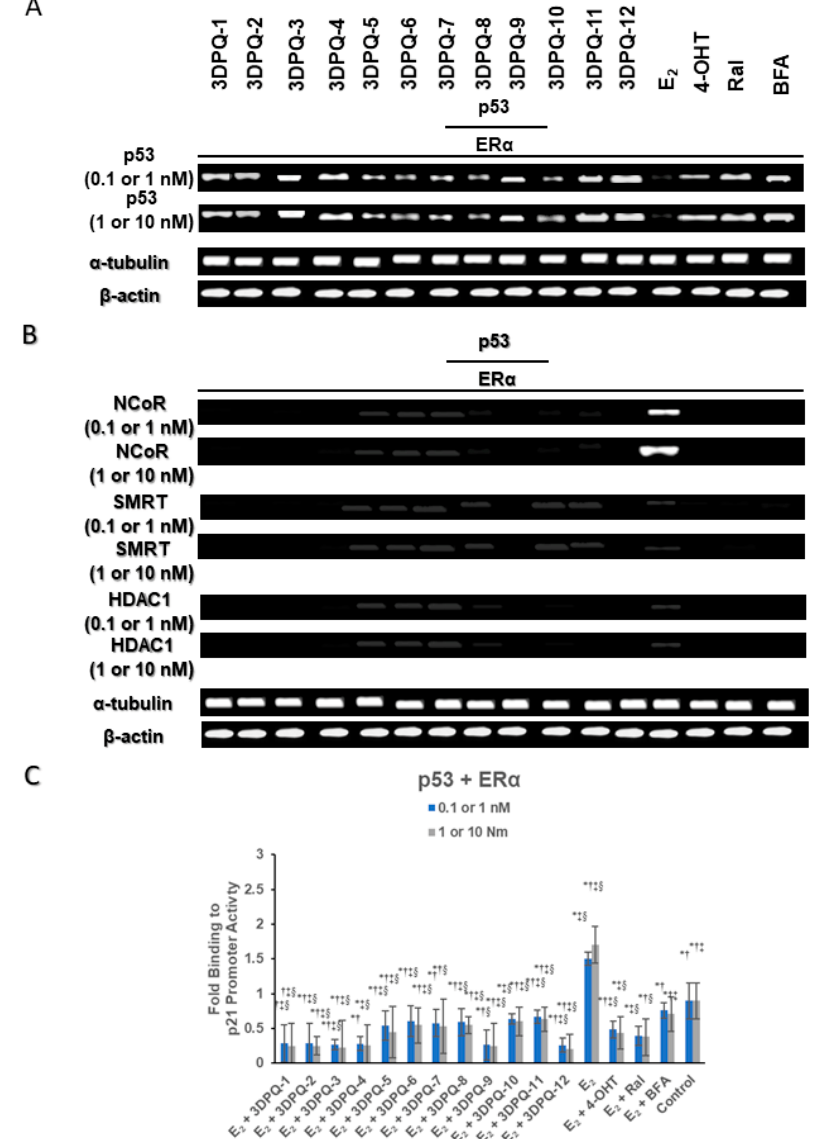
Figure 8. ER α recruits transcriptional corepressors to repress p53-mediated transcriptional activa-